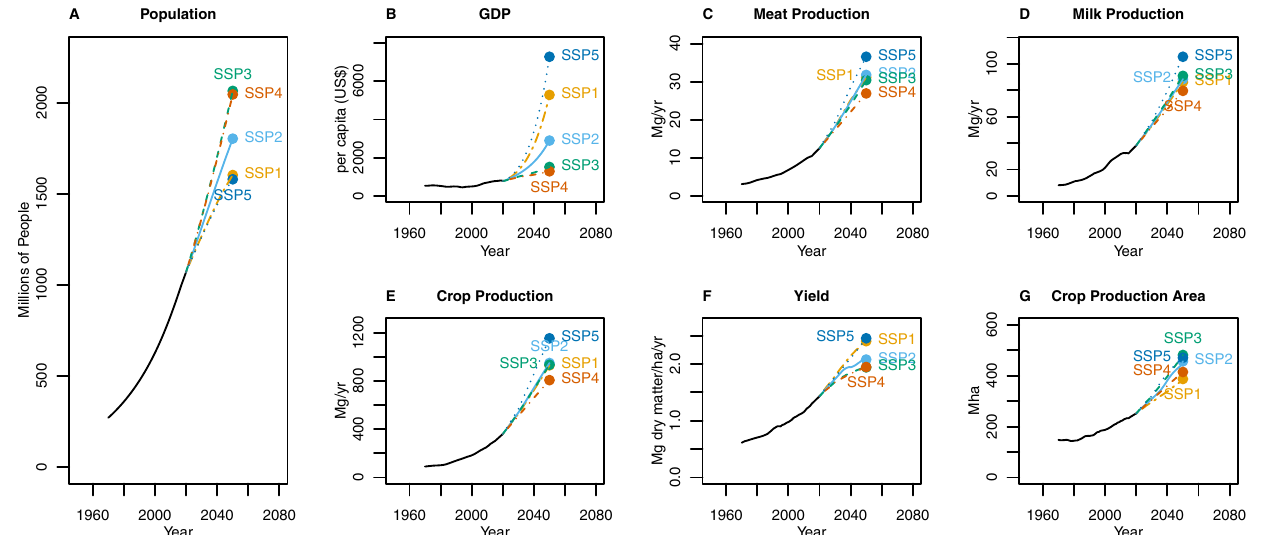
Fig. 1 | Historical and future Sub-Saharan African for different Shared Socio- economic Pathways (SSPs) modelled using IMAGE 3.2. ( A ) population growth (millions of people); B GDP (per capita US$); C Meat production (Mg yr − 1 ); D Milk